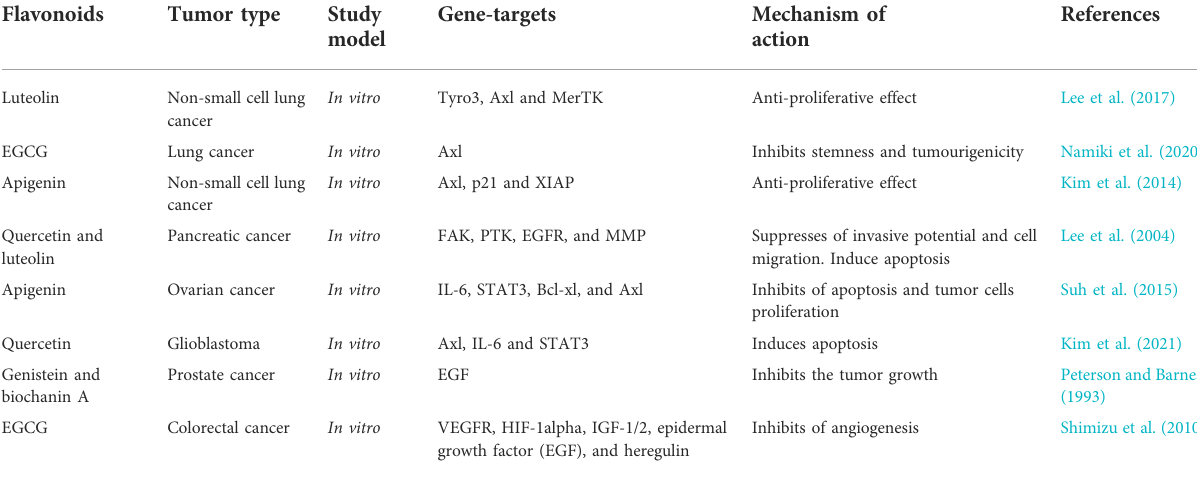
TABLE 6 The antitumor effects of fl avonoids by regulation of receptor tyrosine kinases (RTKs) and integrins.